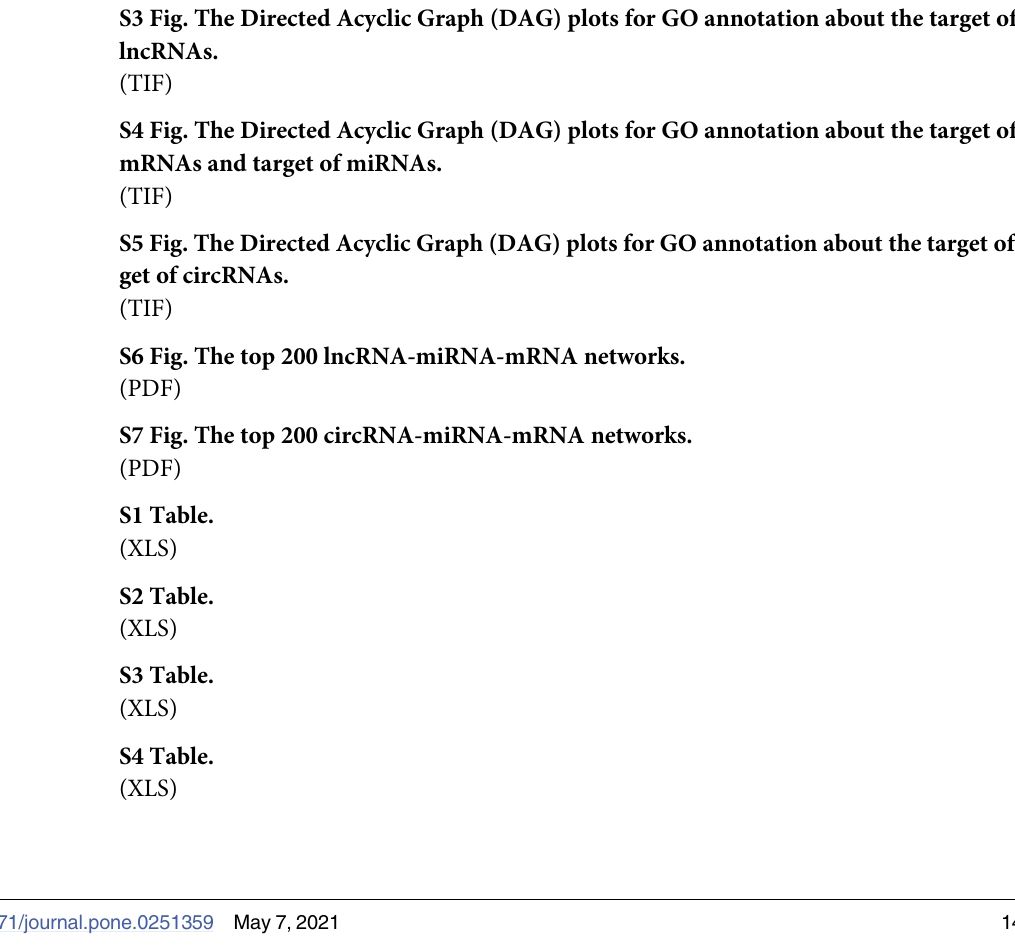
S1 Fig. The pie charts of the distribution of lncRNAs in whole-transcriptome profiles of three pairs ALI and control samples. S2 Fig. (A)-(C) Distribution and length of lncRNAs and mRNAs in whole-transcriptome pro- files of ALI samples. (D) The cumulative distribution of conservative scores of lncRNAs. (E) The pie chart of subtypes of lncRNAs. S3 Fig. The Directed Acyclic Graph (DAG) plots for GO annotation about the target of lncRNAs. S4 Fig. The Directed Acyclic Graph (DAG) plots for GO annotation about the target of mRNAs and target of miRNAs. S5 Fig. The Directed Acyclic Graph (DAG) plots for GO annotation about the target of tar- get of circRNAs. S6 Fig. The top 200 lncRNA-miRNA-mRNA networks. S7 Fig. The top 200 circRNA-miRNA-mRNA